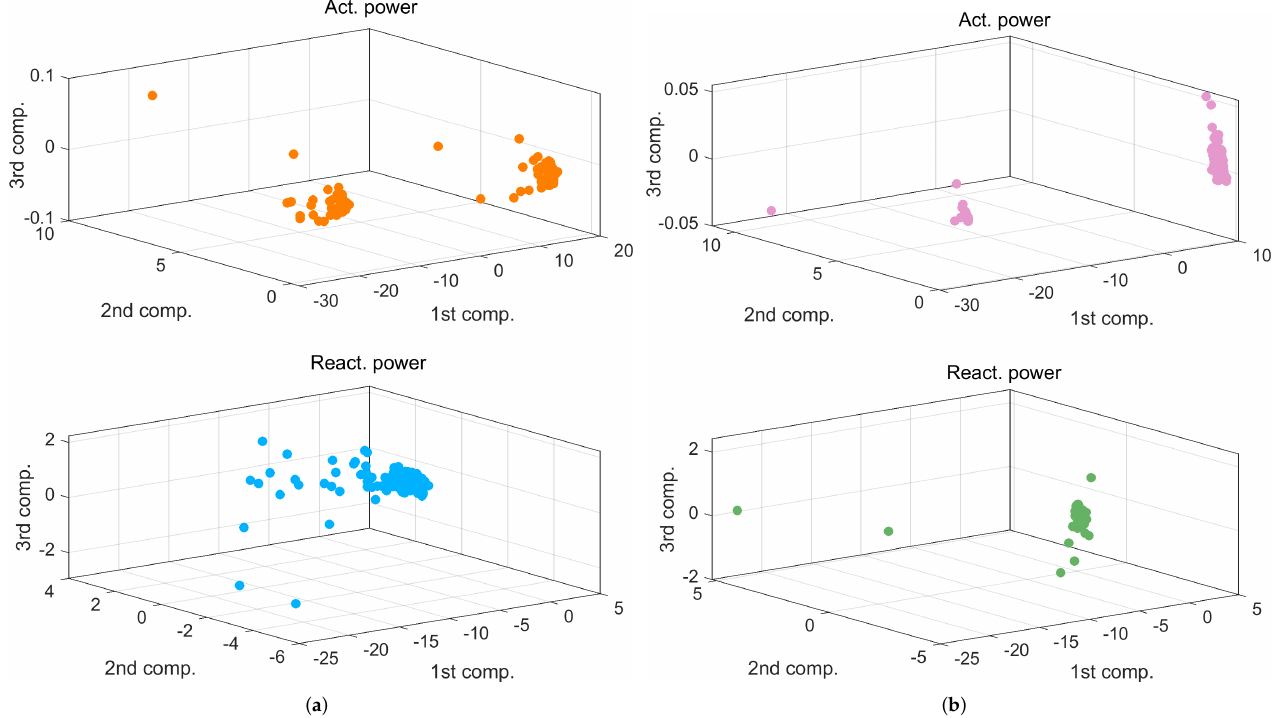
Figure 9. Spatial distribution of the first three PCA components for P h and Q h : ( a ) tractioning,